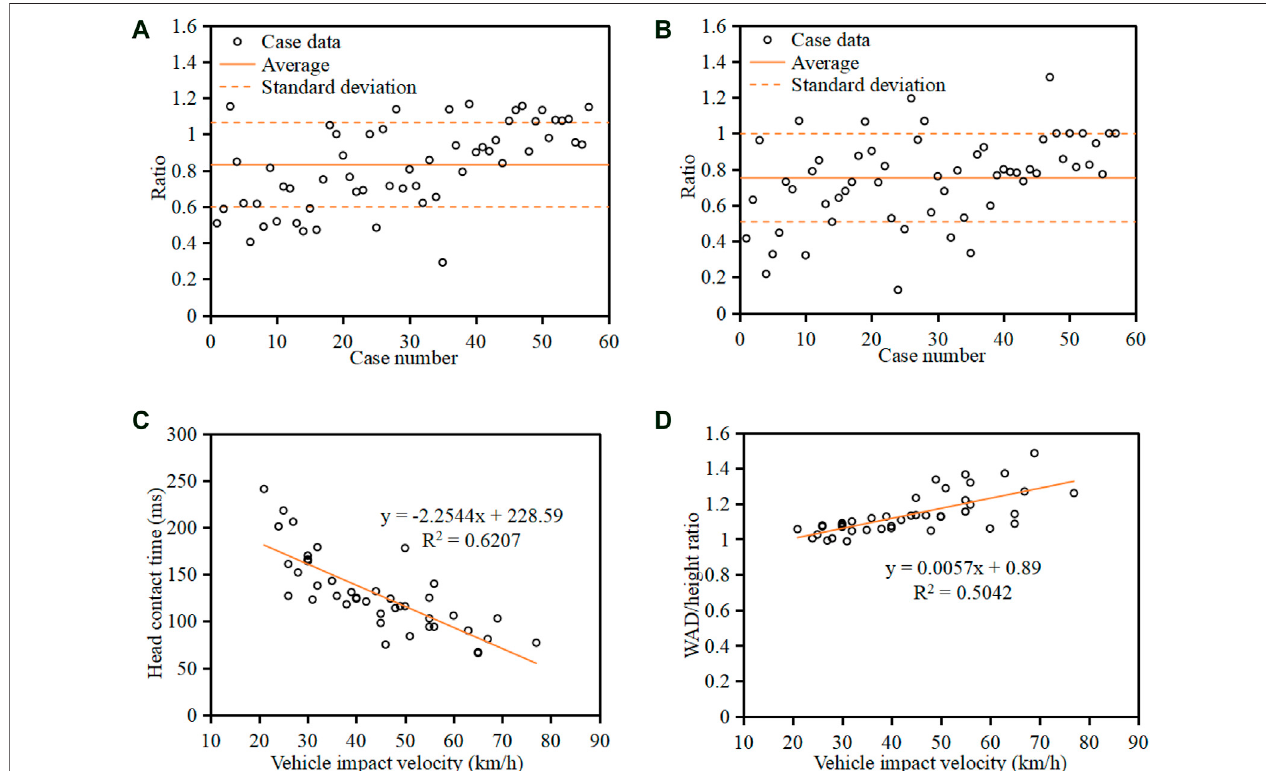
FIGURE 11 | Ratio of head linear contact velocity in km/h (A) and angular contact velocity in rad/s (B) to vehicle impact velocity in km/h and relationships between pedestrian head contact time (C) and WAD/height ratio (D) and vehicle impact velocity for the bonnet-type (sedan and SUV) cars.